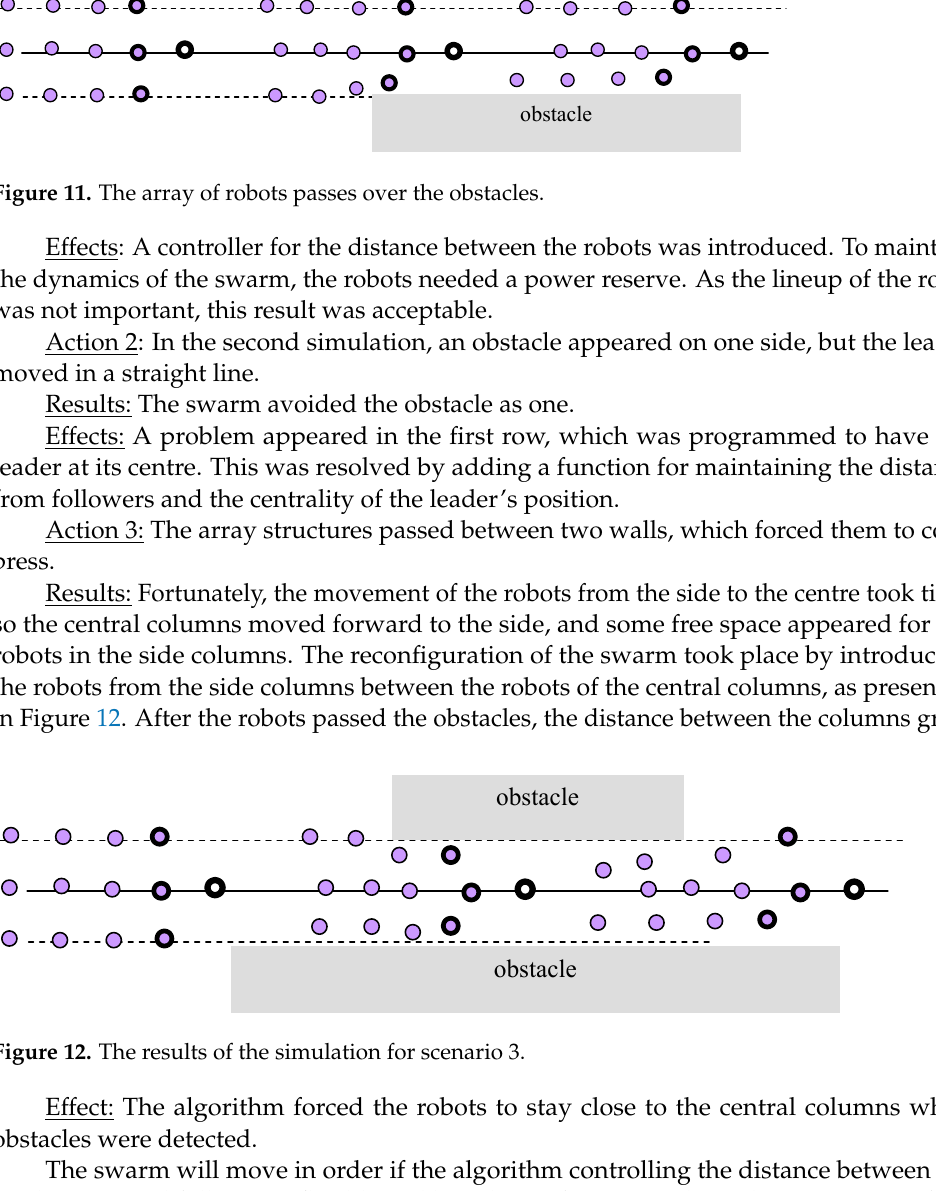
Figure 13. The result of a simulation of array robots following the turning leader.